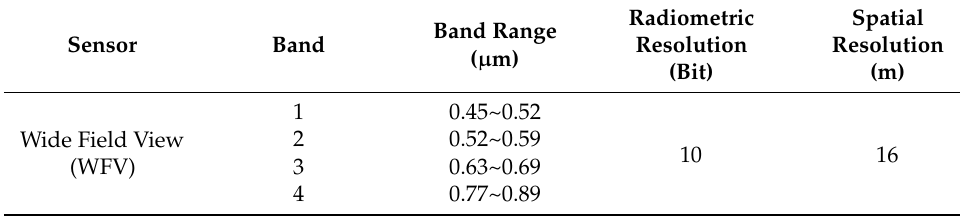
Table 1. GF-1 WFV parameters.